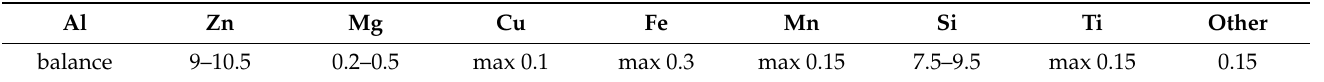
Table 1. Nominal chemical composition of EN AB-71100 aluminum alloy used in the experiment (wt%)